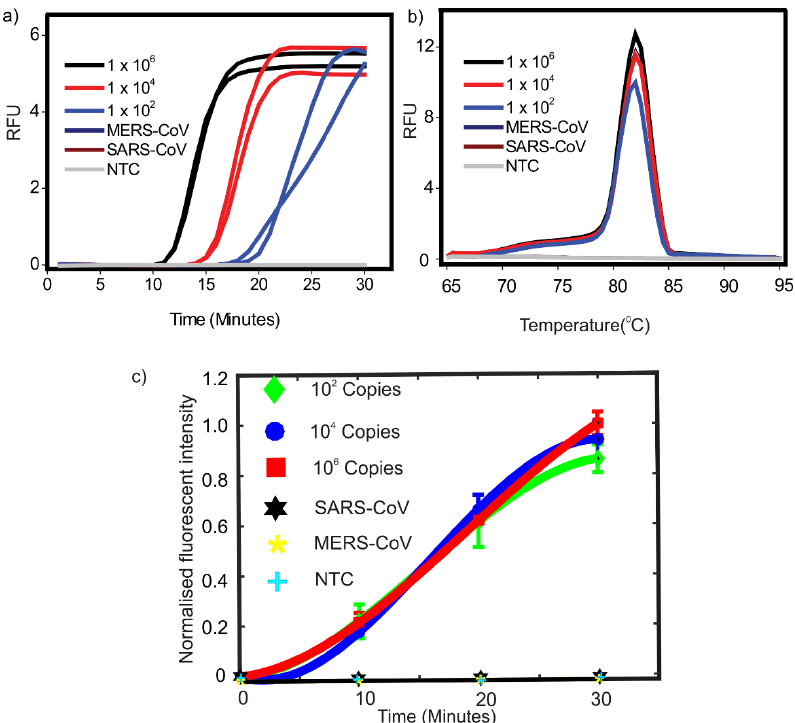
Figure 2. ( a ) Amplification curves obtained for LAMP reactions carried out on conventional qPCR machine. ( b ) Corresponding melt peaks. For MERS-CoV and SARS-CoV controls see Section 2.1 for details. NTC = no-template control. ( c ) Variation of normalised fluorescent intensity of various samples with respect to time on performing the LAMP.